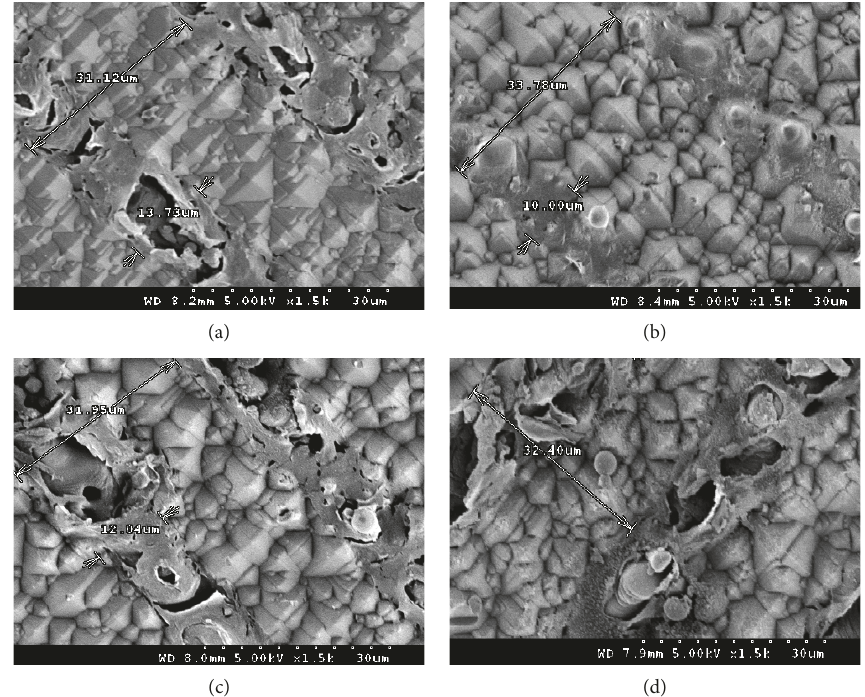
Figure 3: FESEM surface morphology images of backside surfaces of SPMSCs with various laser powers of (a) 0.8, (b) 1.0, (c) 1.2, and (d) 1.4W.